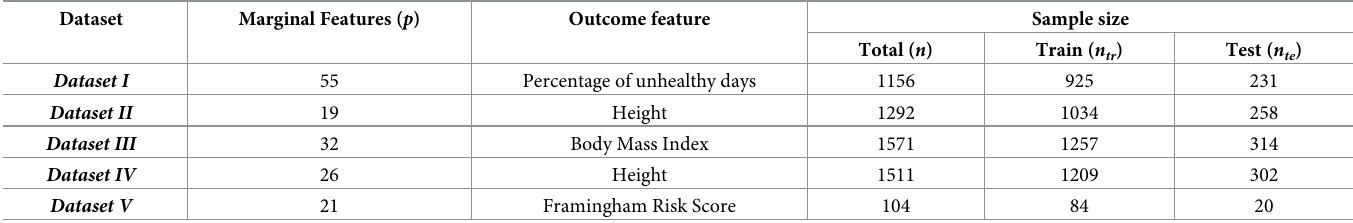
Table 6. Summary of the real